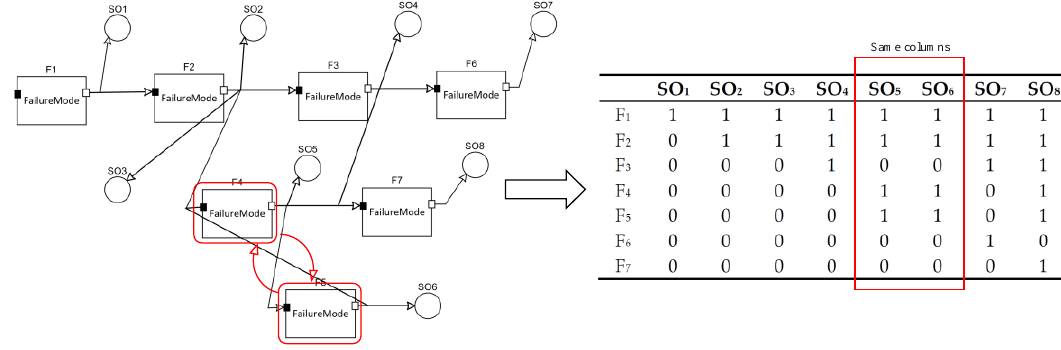
Figure 7. The equivalent sensors.